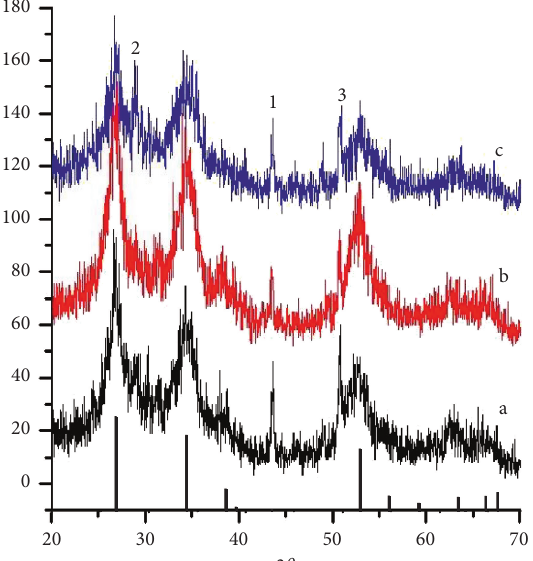
Figure 4: XRD patterns of SnO 2 -doped Sb thin films on 316L stainless steel at different pH solutions. (a) pH peaks of SnO 2 (adapted from [7]) are present as the vertical black bars on the